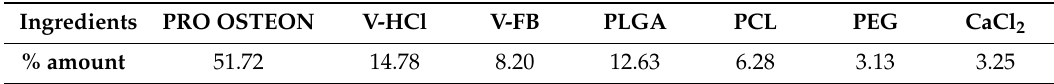
Table 1. The % amount of ingredients in the antibiotic-releasing bone void filler (ABVF) formulation. Ingredients PRO